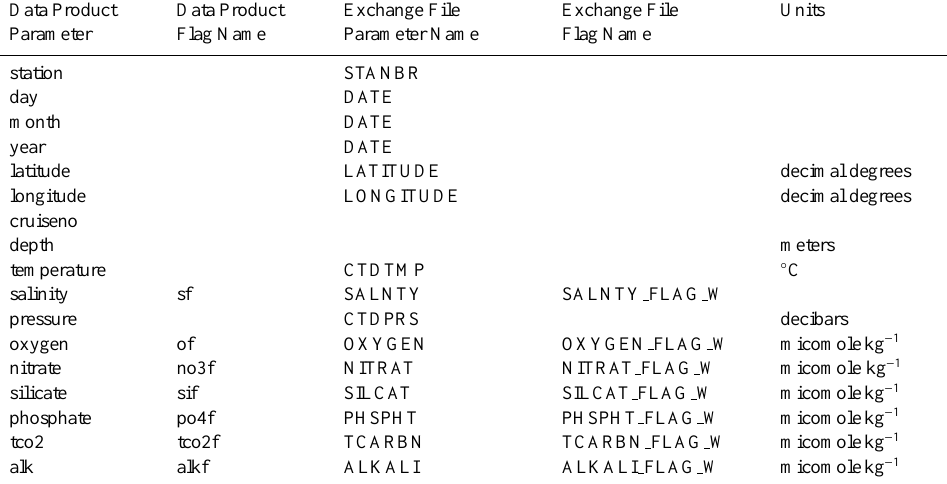
Table of parameters relevant for this review. For a list of all properties in the CARINA data base see Key et al.